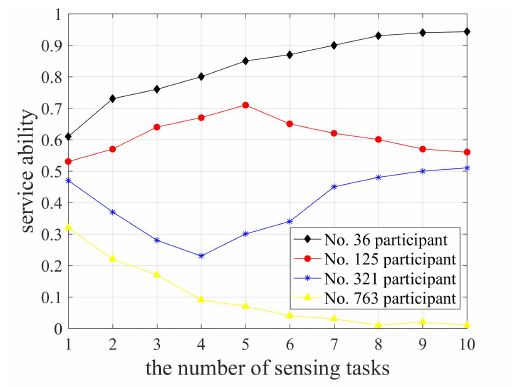
Figure 2. Changes in the service ability of participants.